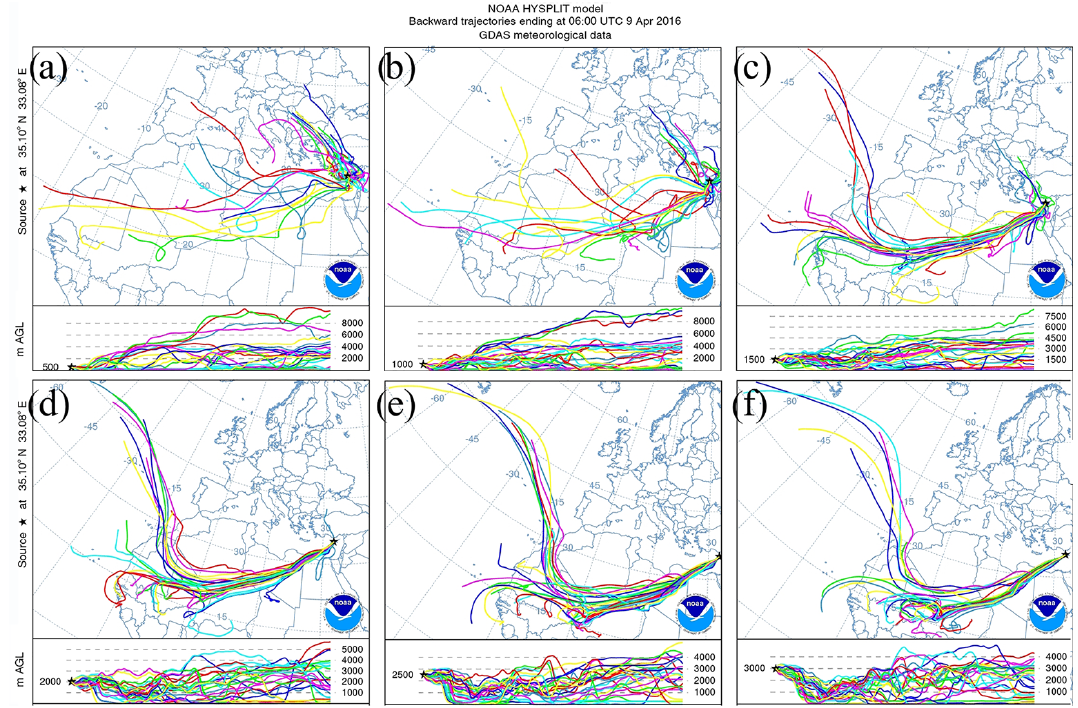
Figure 15. Ensembles of 27 seven-day HYSPLIT backward trajectories (Stein et al., 2015; Rolph, 2016) for the starting heights of 500 (a) ,